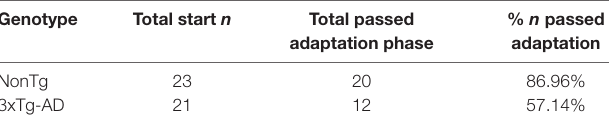
TABLE 1 | A higher percentage of NonTg mice were able to learn to enter a corner and drink from the waterspout compared to 3xTg-AD mice, resulting in a higher exclusion of 3xTg-AD mice from the subsequent IntelliCage